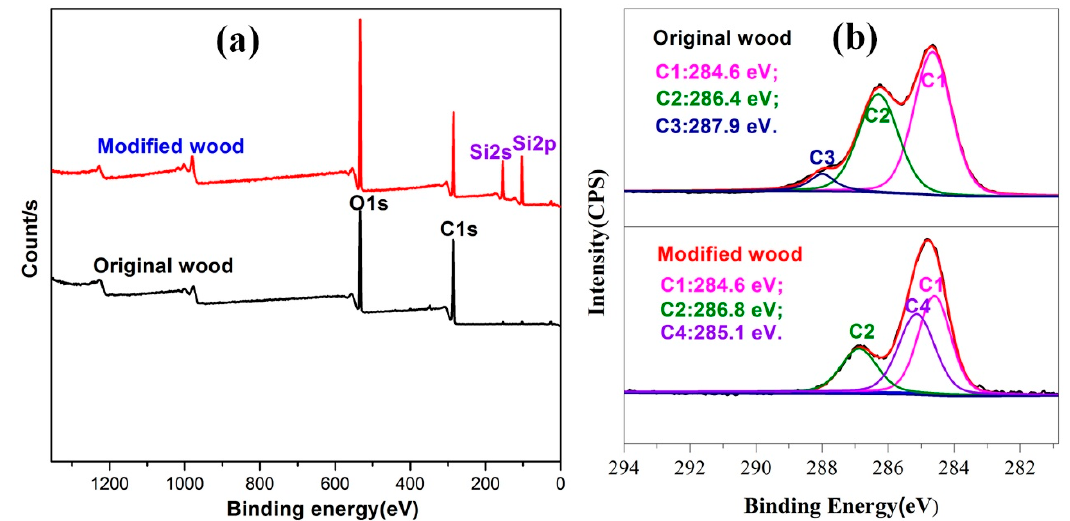
Figure 4. XPS spectra of original and modified wood ( a ) and high-resolution spectra of C1s ( b ).